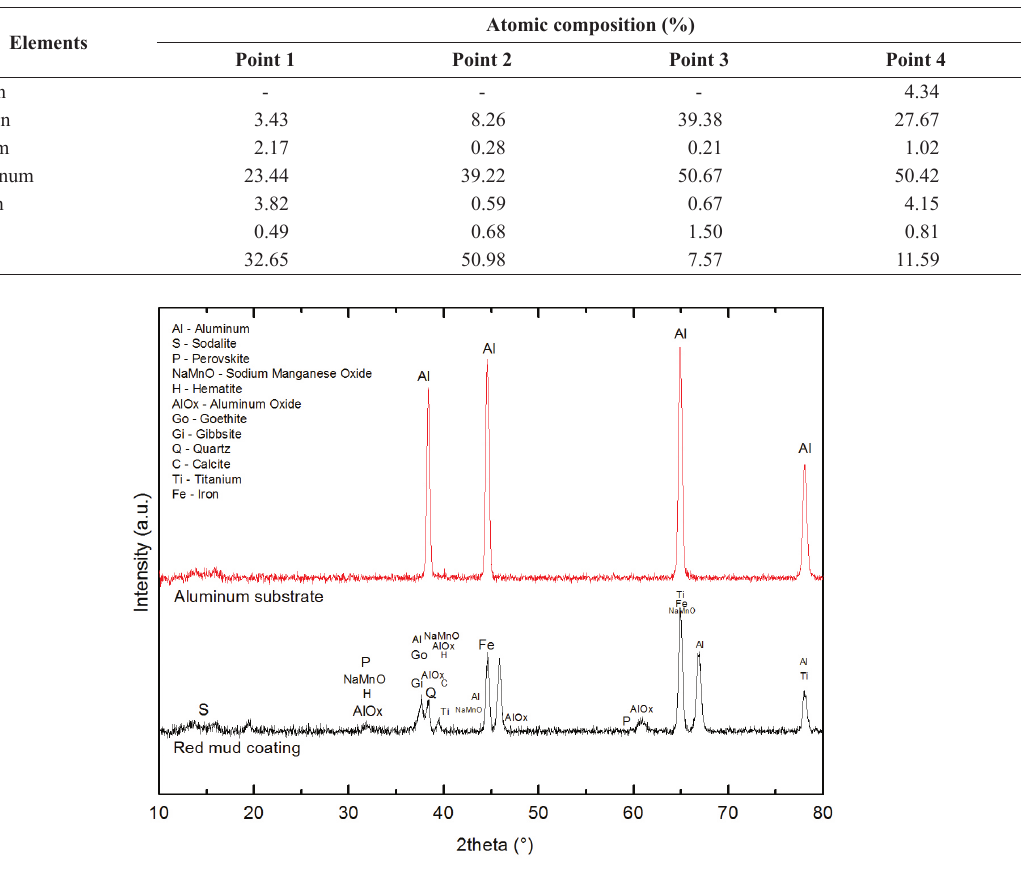
Figure 8. XDR patterns of aluminum substrates and red mud